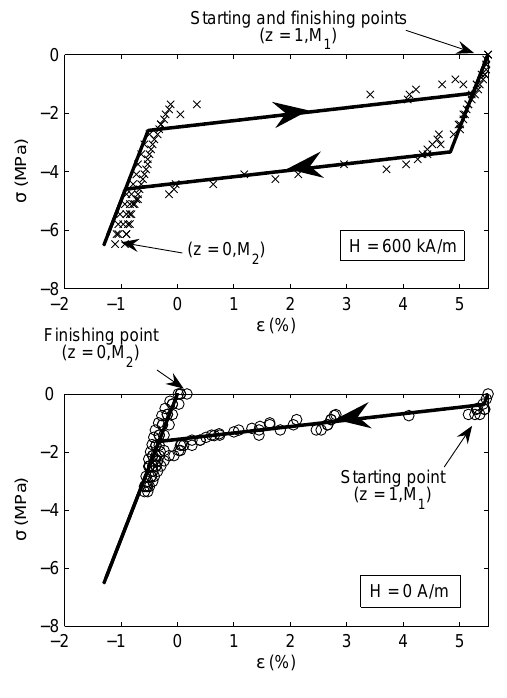
Figure 3: Strain vs stress plots for two different mag- netic fields: model prediction (solid line) and experiments (crosses or circles)